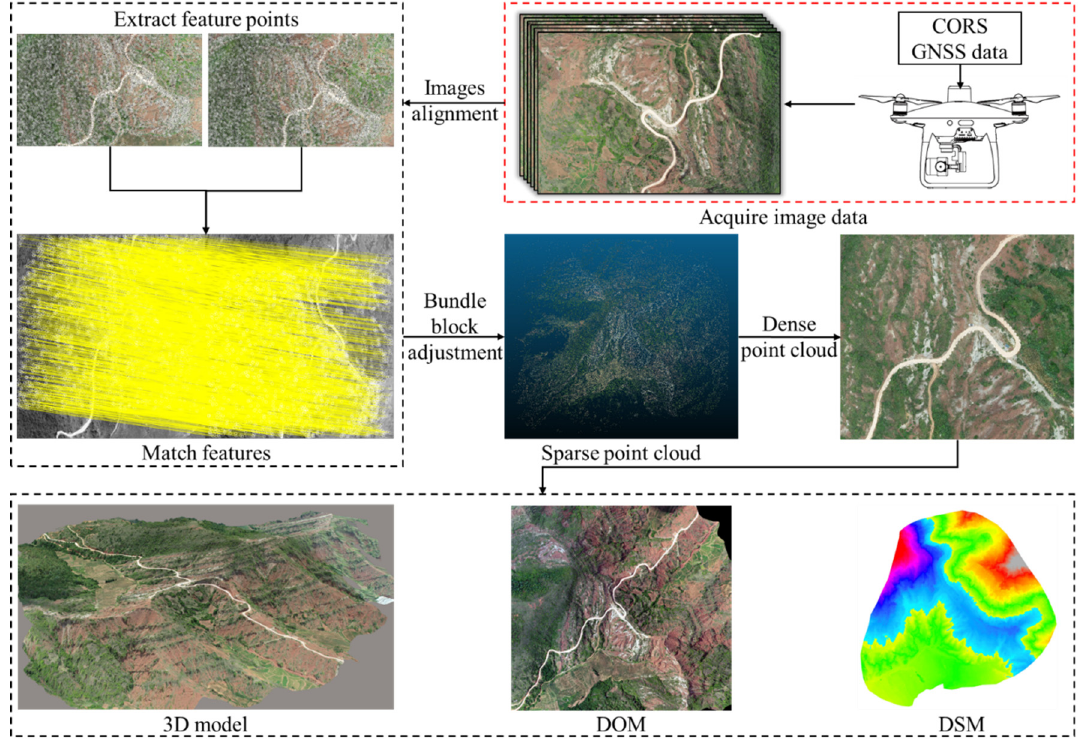
Figure 4. 3D scene construction process of SfM-MVS technology.